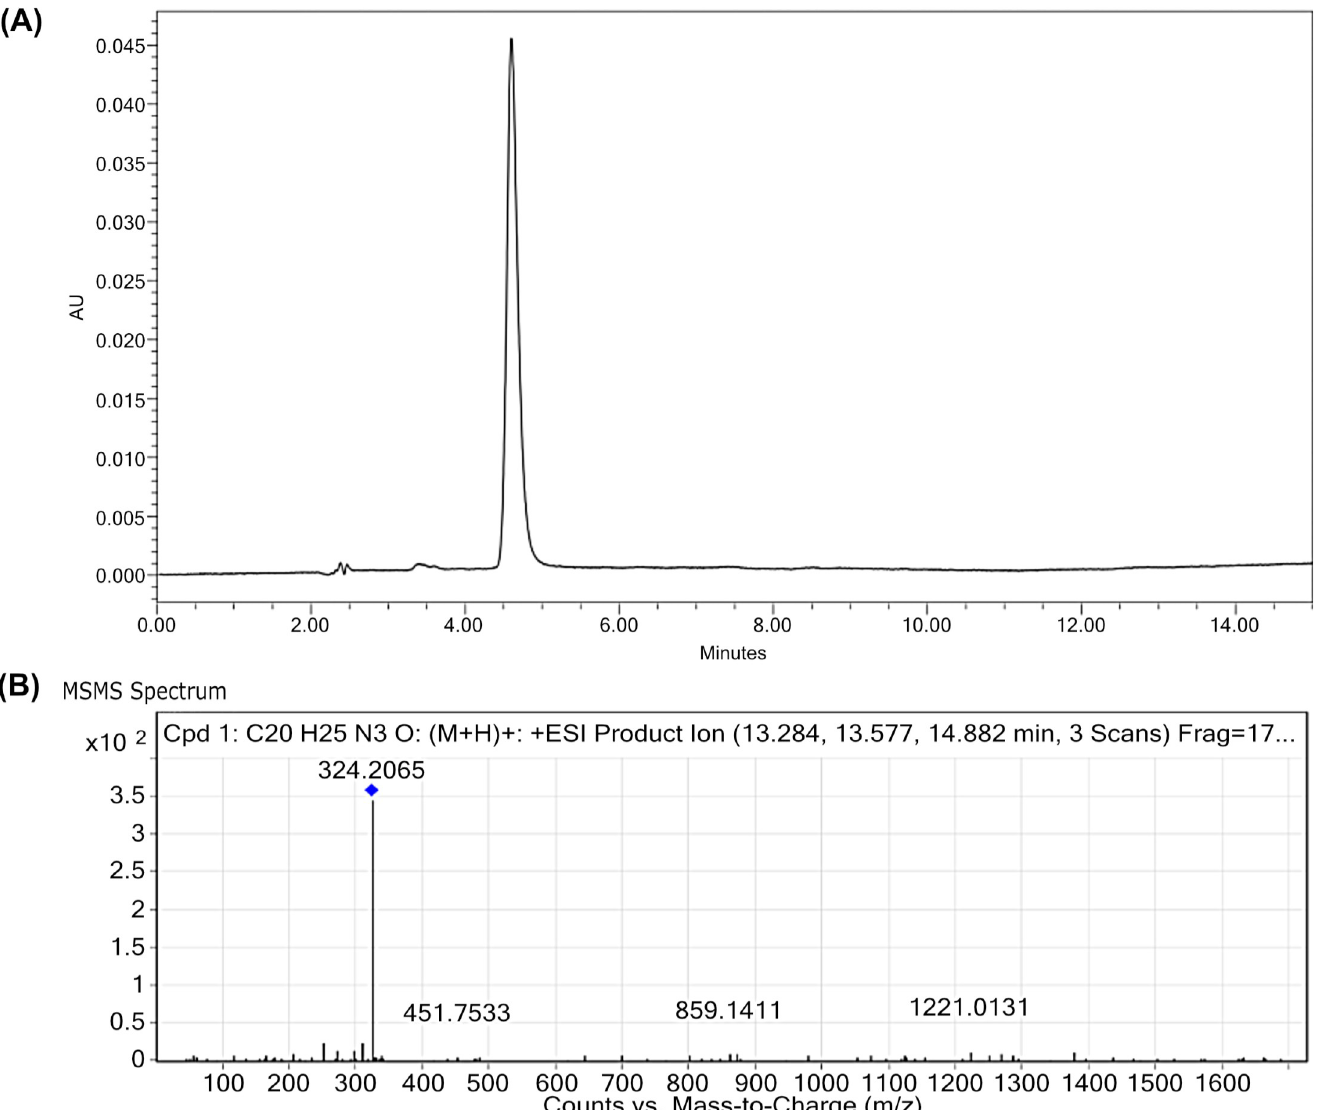
Fig 3. Identification of prodigiosin in the crude extract. Prodigiosin is detected at the (A) retention time of ~4.75 minutes by HPLC. (B) The molecular weight of prodigiosin (324.2068 g mol -1 ) was detected from the LC-MS/MS analysis.